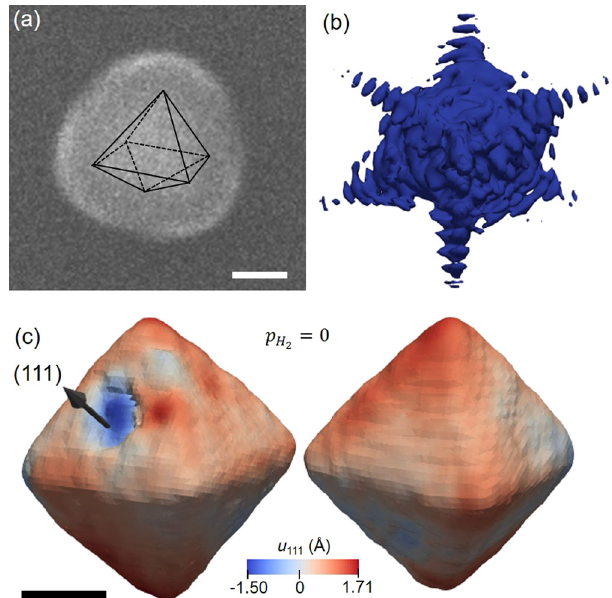
Fig. 1 Imaging the displacement fi eld of the octahedral Pd nanoparticle. a Scanning electron microscopy image of an individual Pd nanoparticle, showing the TiO 2 layer surrounding the metallic core. The black lines are a guide for the eyes, distinguishing the Pd surface and the titanium dioxide. b Isosurface of the 3D diffraction pattern obtained from the Pd nanoparticle ¼ 0 Þ . c Different views of the measured under the pristine state ð p H 2 reconstructed displacement fi eld for the pristine state nanoparticle shown as an isosurface, colored according to its displacement component along the [111] direction, u 111 . The black arrow represents the [111] direction of the measurement Q-vector. The scale bars in ( a ) and ( c ) represent 100